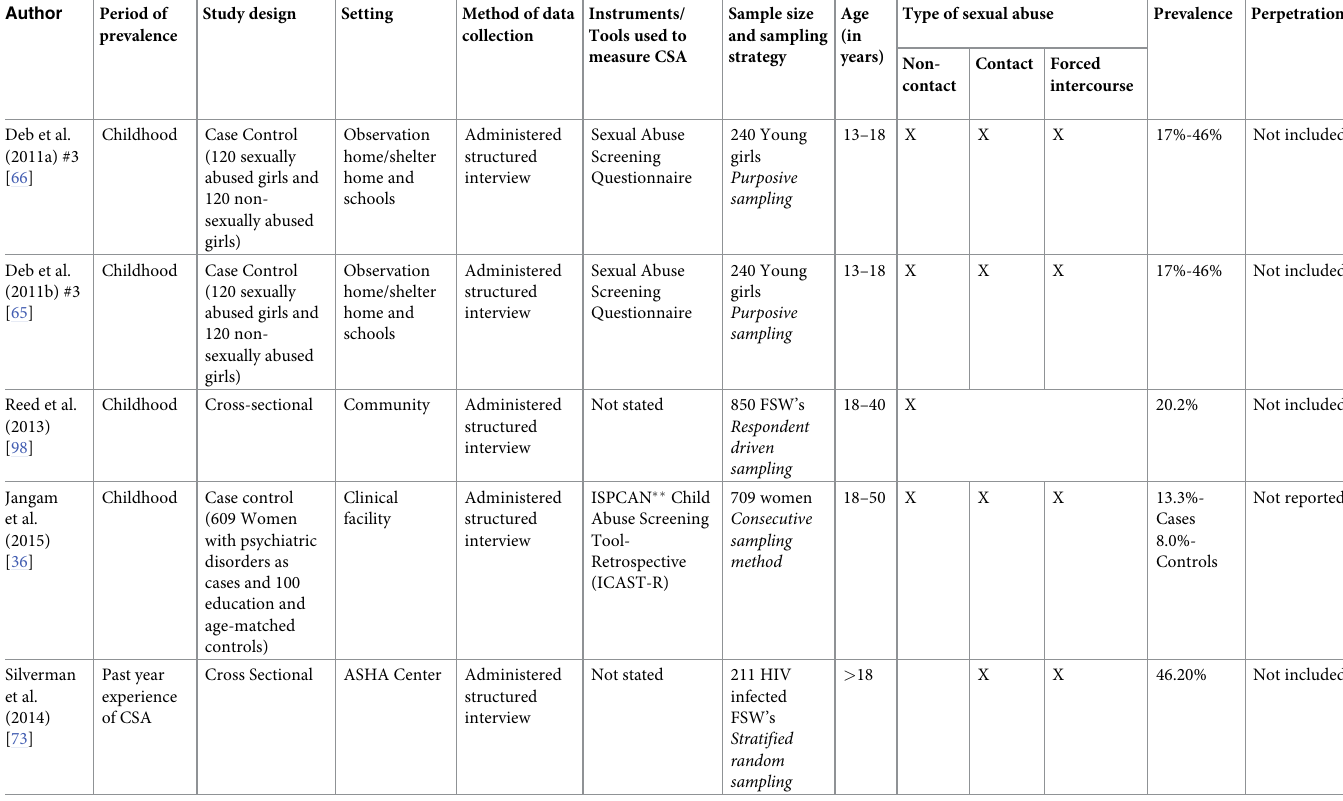
Table 7. Characteristics of quantitative and mixed-method studies included in the review with populations at